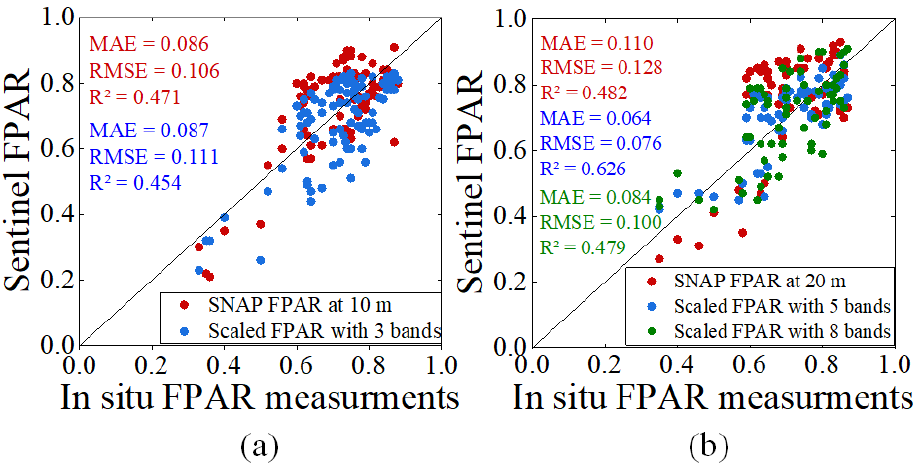
Figure 3. Comparison of the in situ FPAR measurements and Sentinel FPAR retrievals from the ( a ) 10 m spatial resolution and ( b ) 20 m spatial resolution.